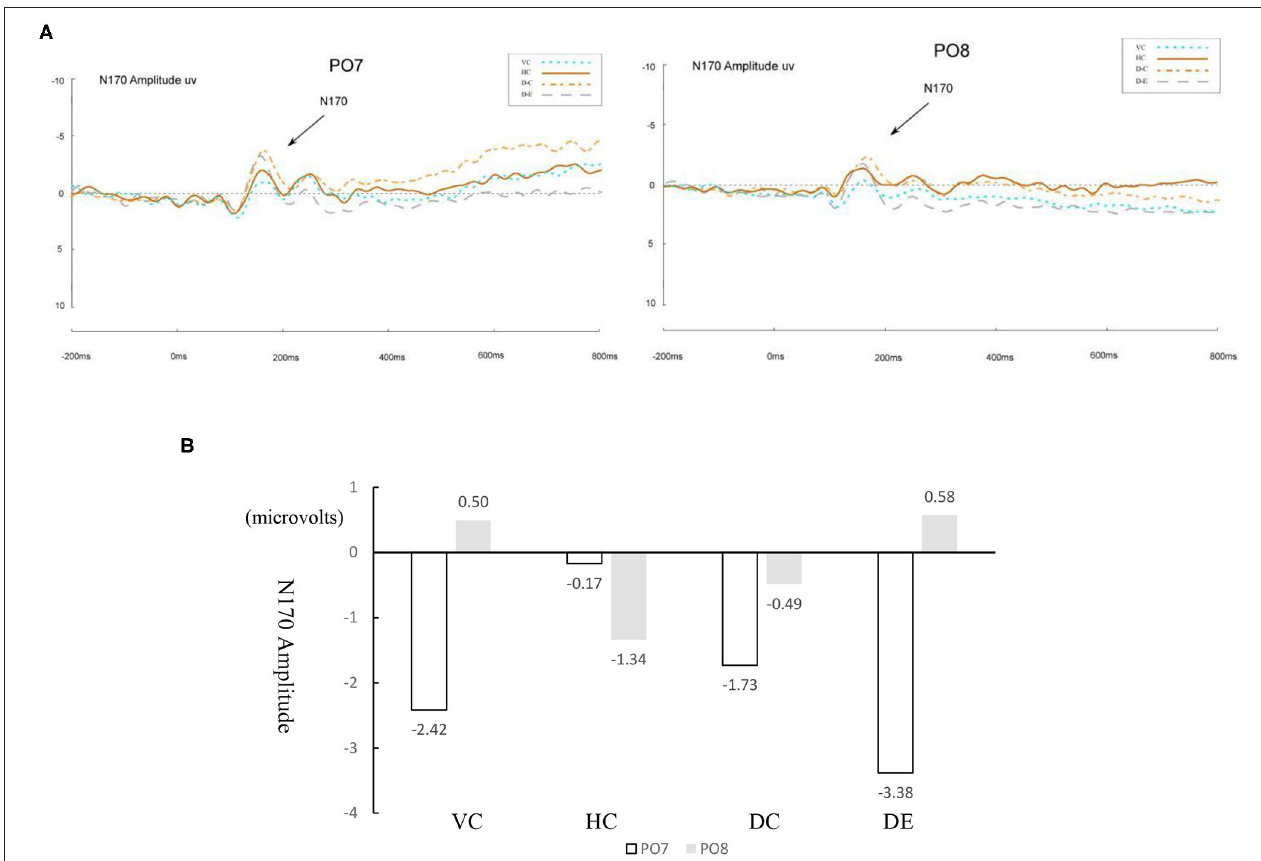
FIGURE 4 | (A) ERP waveforms of N170 under four conditions for dyslexic readers for the left (PO7) and right (PO8) parietal leads. VC, viewing-Chinese; HC, handwriting-Chinese; DC, drawing followed by Chinese recognition; DE, drawing followed by English recognition. (B) Differences between four conditions for dyslexic readers in the amplitude of N170.